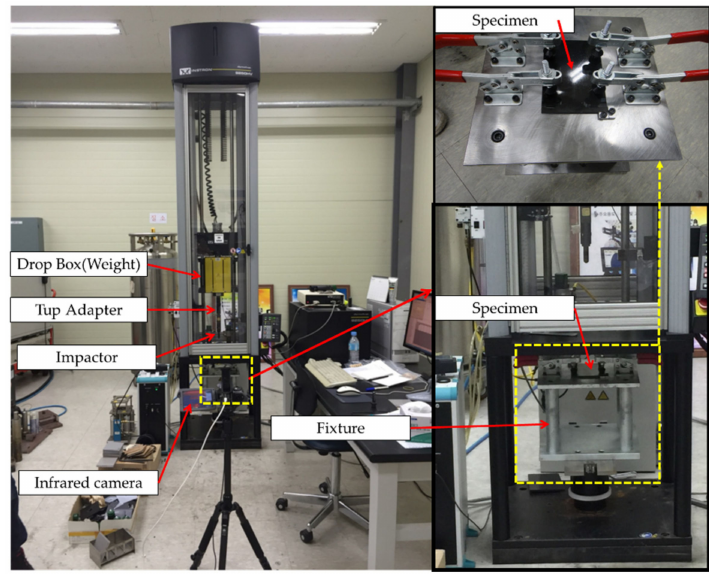
Figure 2. Experimental